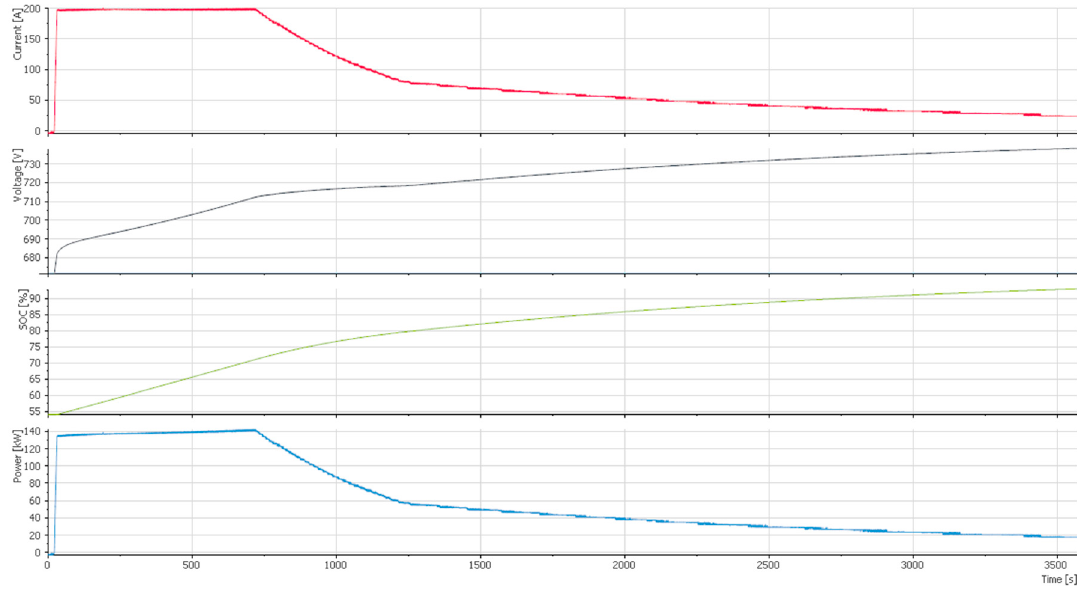
Figure 8. Voltage, current, state of charge and charging power while DC charging (CCS2 interface).